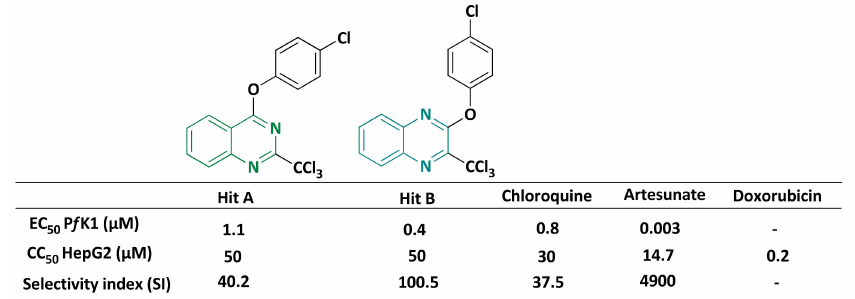
Figure 1. Comparison of biological activities between hit A, hit B and reference drugs.